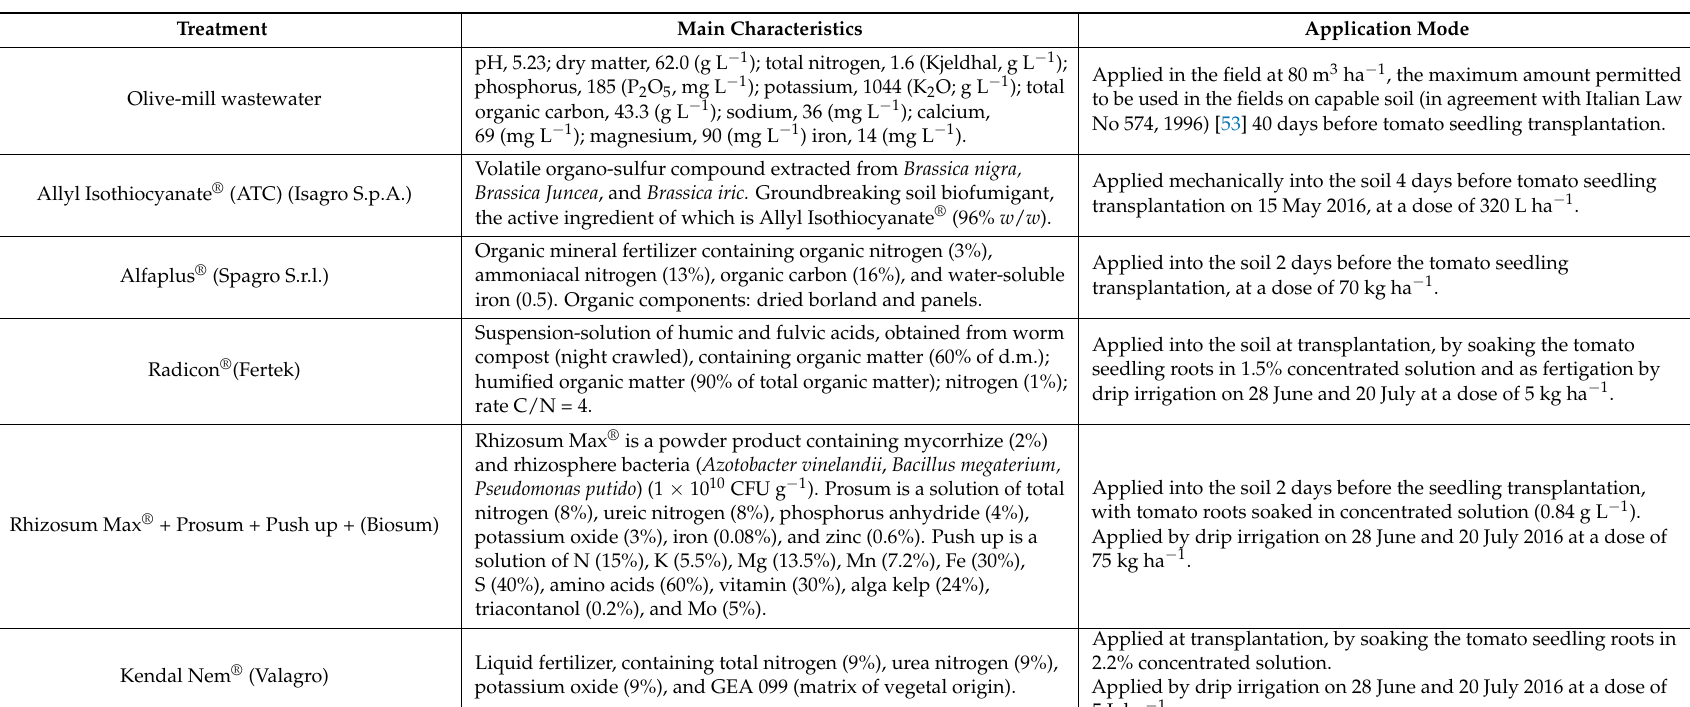
Table 3. Composition and application mode of the products used in the